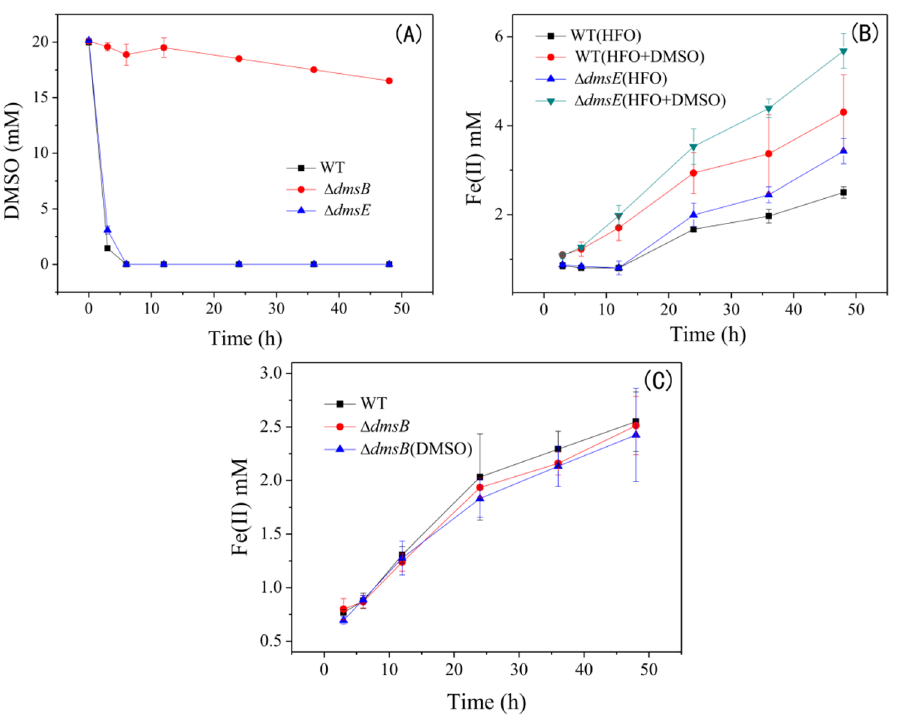
Figure 2. DMSO reduction by WT, D dmsE and D dmsB (A). HFO reduction by D dmsE (B) and D dmsB (C) compared with WT with dose of 20 mM DMSO. The data are the average of triple samples and the error bars represent standard deviation.